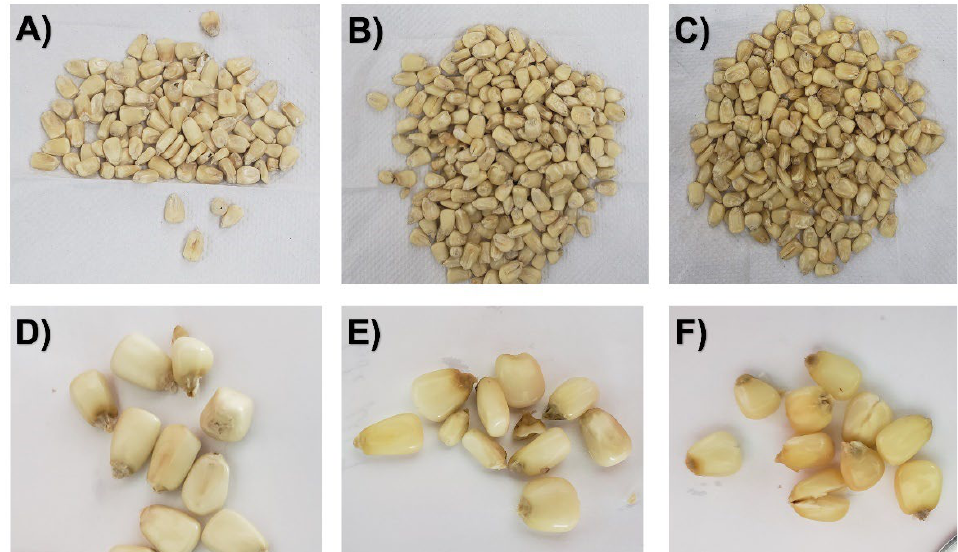
Figure 6. Dried and rehydrated maize kernels: ( A ) Dried control, ( B ) Dried DIC 14 (P = 0.4 MPa, t = 90 s), ( C ) Dried DIC 18 (P = 0.4 MPa, t = 90 s divided into nine cycles of 10 s), ( D ) Rehydrated Control, ( E ) Rehydrated DIC 14, and ( F ) Rehydrated DIC 18.